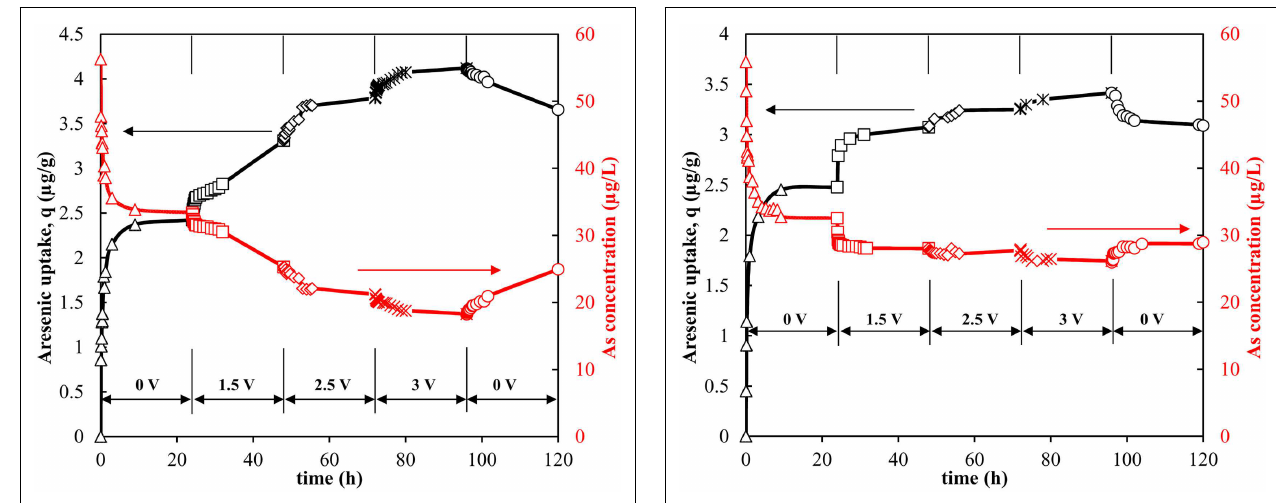
FIGURE 4 |Arsenic uptake (black line) and remaining concentration (red line) as a function of time during the adsorption and electroadsorption experiment in anodic treatment (GAC on the anode compartment) .Voltage was varied sequentially during the experiment as follows: (i) normal adsorption in absence of current (triangle); (ii) electroadsorption at 1.5V (square); (iii) electroadsorption at 2.5V (diamond) (iv) electroadsorption at 3.0V (asterisk); (v) arsenic desorption in absence of current (circle).